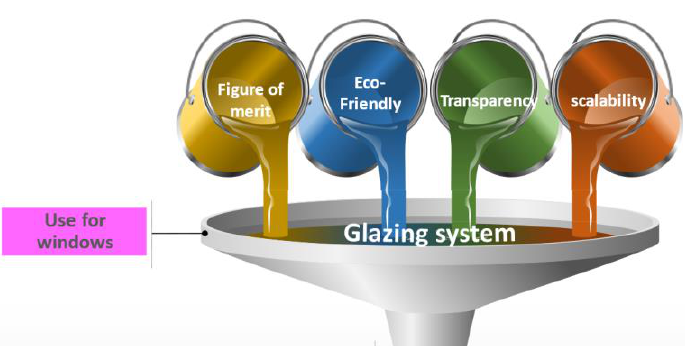
Figure 2. Schematic illustration of the areas to be focused on for developing TE glazing modeling.